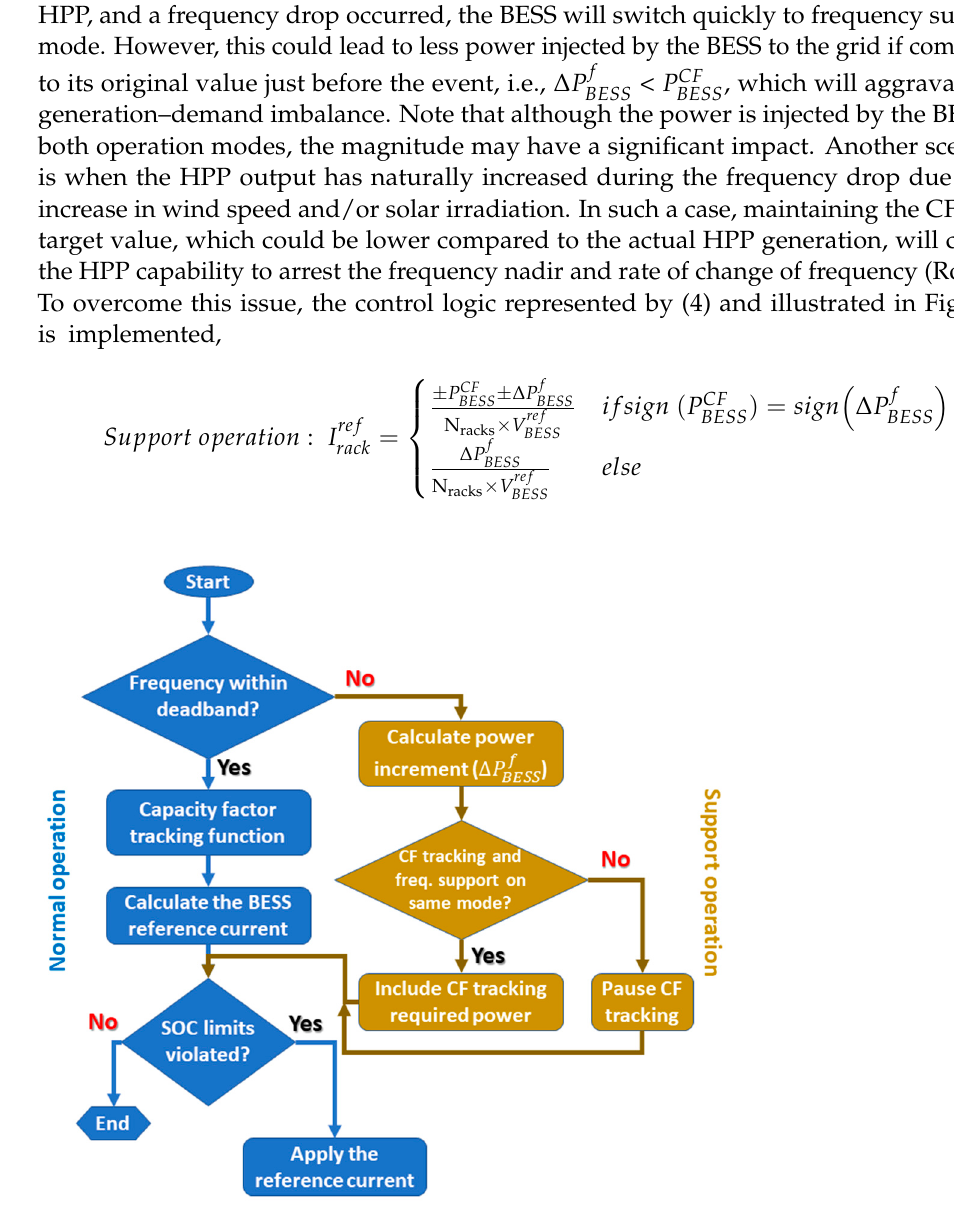
Figure 2. Flowchart of the proposed coordination between frequency support and CF tracking.